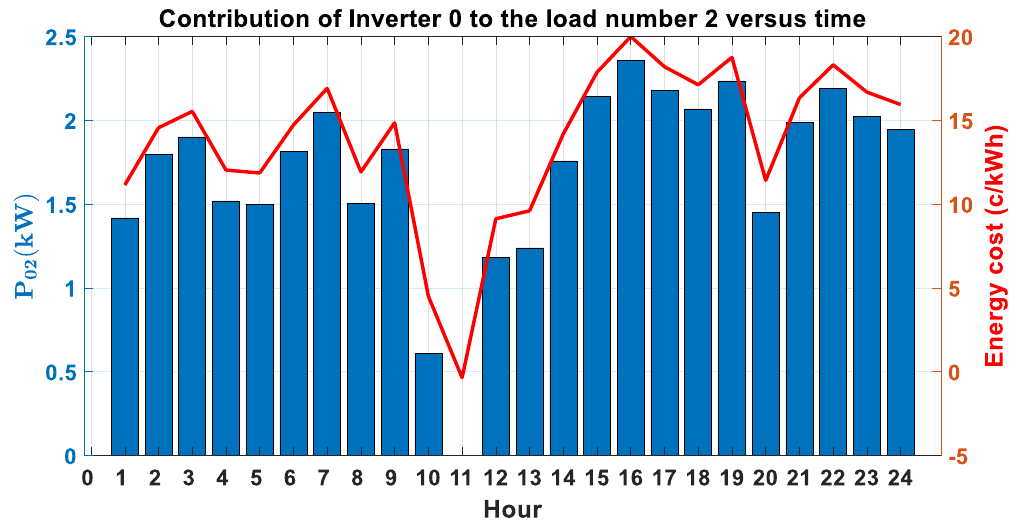
Figure 2. Contribution of inverter 0 to load 2 along with the electricity price.